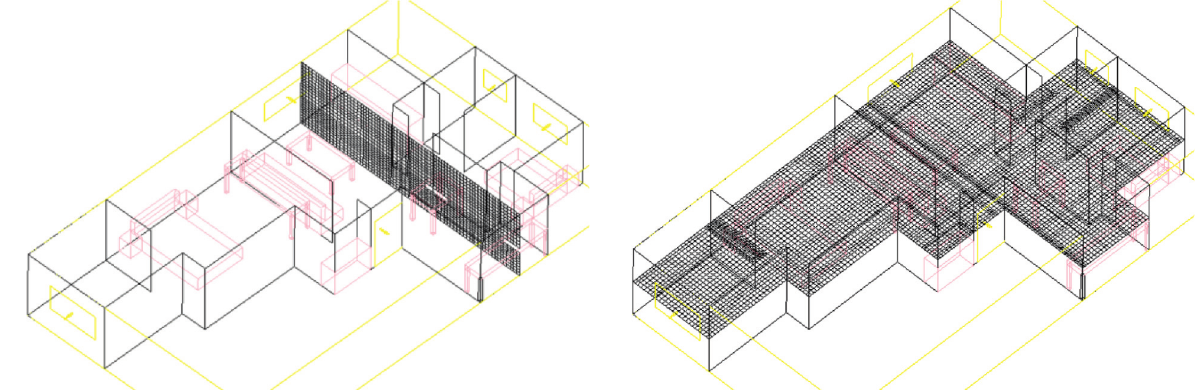
Figure 4: Grid division of house type B along the (a) X axis and (b) Y axis.